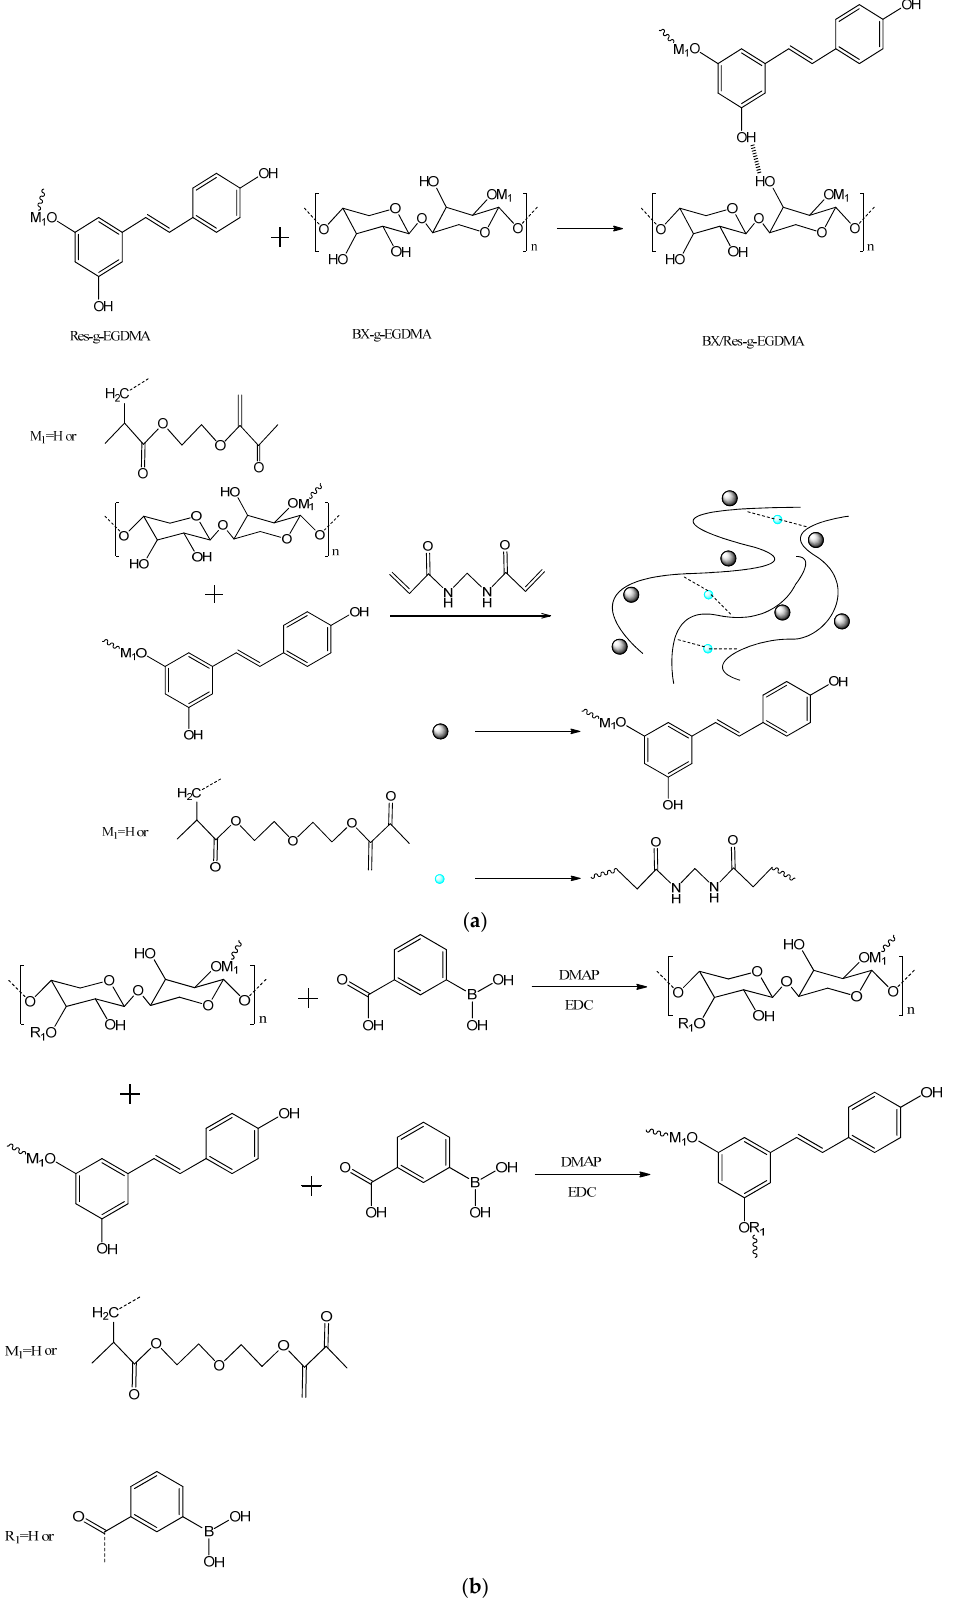
Figure 1. ( a ) The synthesis routes of BX/Res-g-EGDMA and ( b ) 3-CBA-BX/Res-g-EGDMA.